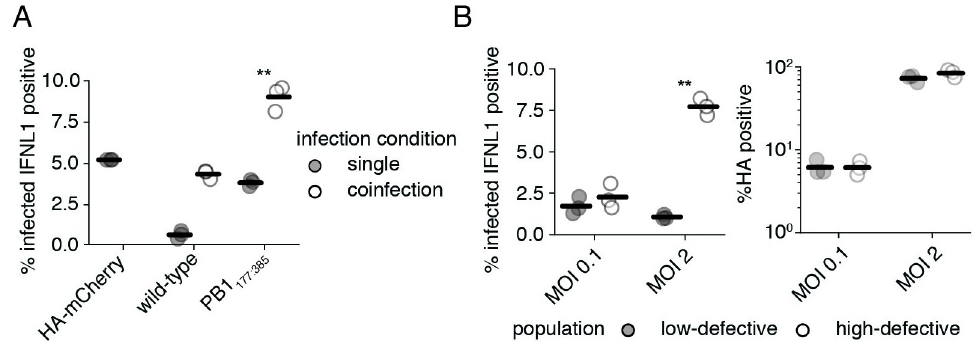
Fig 7. Coinfection increases interferon induction by defective particles. (A) Coinfection with a complementing virus increases interferon induction by PB1 177:385 . Type III interferon reporter A549 cells were infected with PB1 177:385 or wild- type influenza at an MOI of 0.1, and HA mCherry pseudovirus at an MOI of 0.5. Interferon expression was measured in HA- stained cells at 13h post infection. Cells from single infections were called as infected if they stained positive for HA or expressed mCherry. Coinfections required co-staining for both HA and mCherry. Asterisks indicate conditions under which coinfection led to a significant increase in interferon from both HA mCherry and the indicated variant alone, one- tailed t-test. Gating schema shown in S18 Fig for HA and mCherry, and S19 Fig for interferon. (B) Populations replete in defective particles exhibit much higher interferon induction under high MOI infections where coinfection is common. (left) The fraction of HA-positive cells expressing interferon. (right) The total fraction of HA-positive cells. Type III interferon reporter A549 cells were infected with a low-defective or high-defective population as described in S6 Fig. Cells were then infected at a genome-normalized MOI as calculated from the low-defective population and stained for HA and analyzed for interferon reporter expression after 13h. Gating schema shown in S20 Fig. For panels (A) , and (B) , individual points are individual measurements, lines are mean values. For panels (A) , and (B) siginficance was calculated using Benjamini-Hochberg correction at an FDR of 0.05.